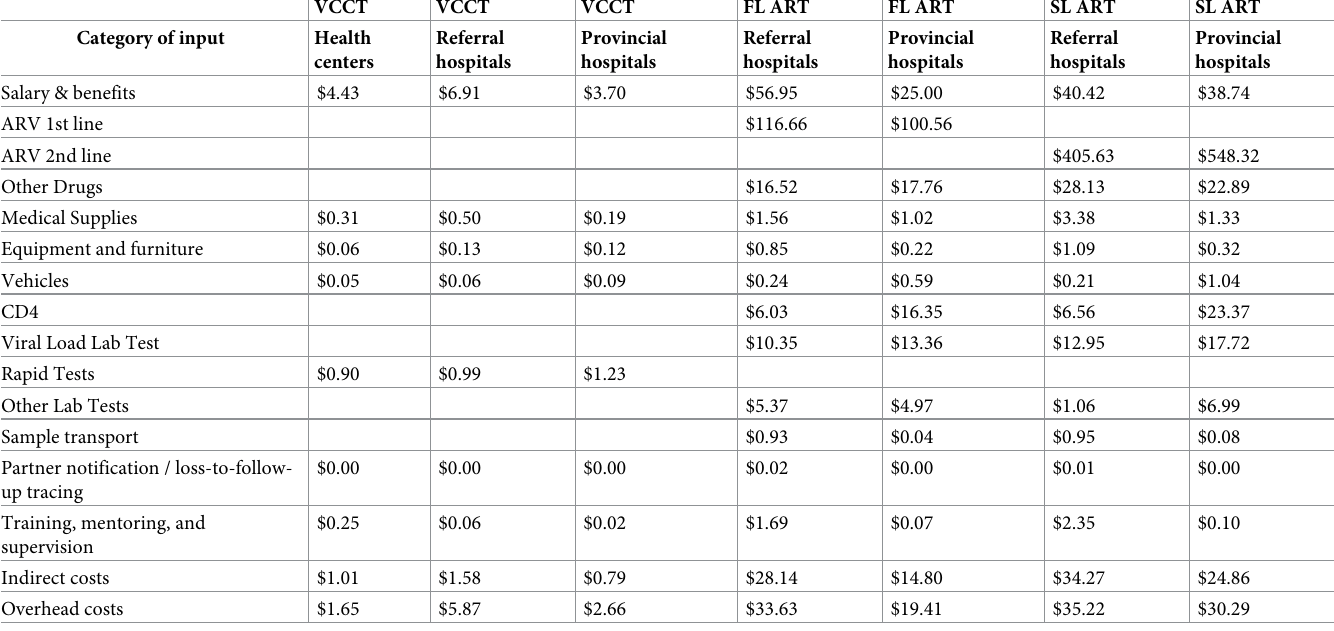
Table 7. Unit cost of services by category of input.